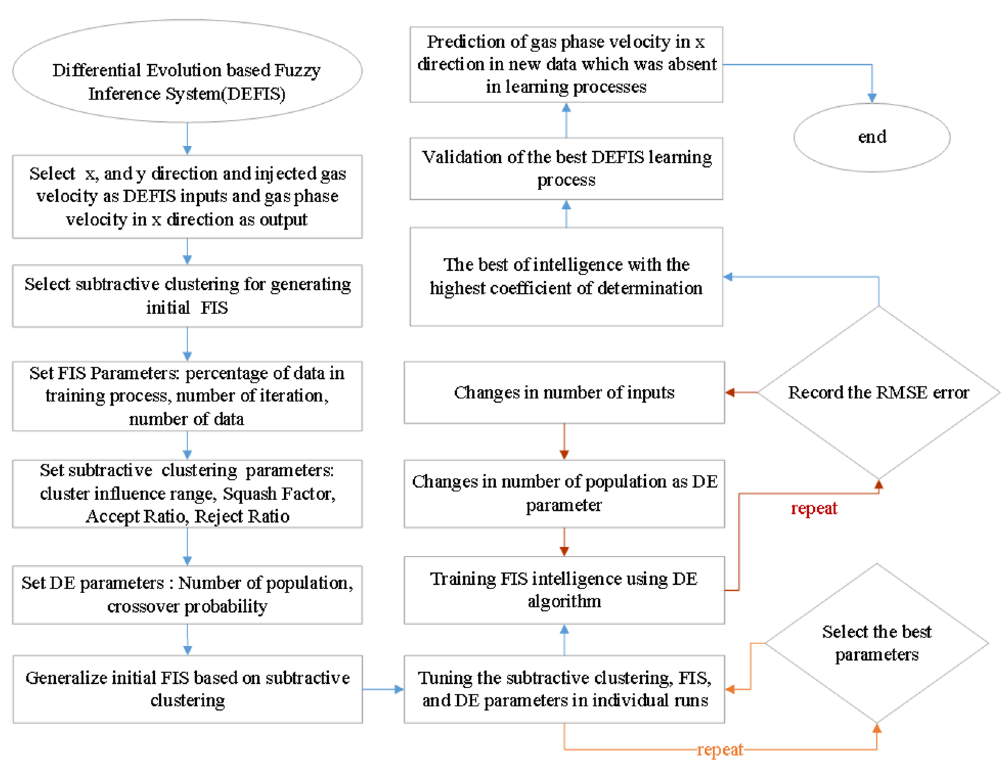
Figure 10. Flowchart of DEFIS